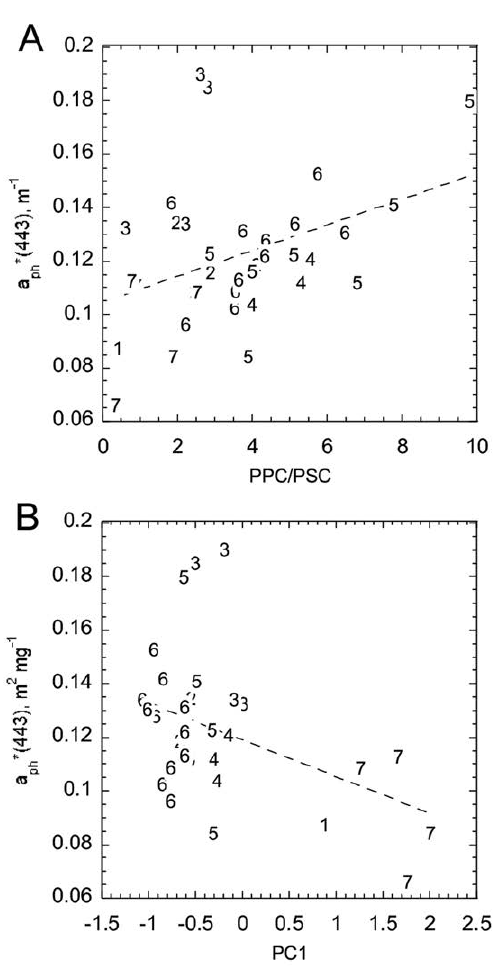
Fig. 11. – Relationships of a *(443) with the ratio PPC/PSC ph [a *(443)=PPC/PSC*0.0048 + 0.105, n=35, r 2 =0.15, p<0.05; ph Spearman´s rank correlation coefficient not significant] (A)